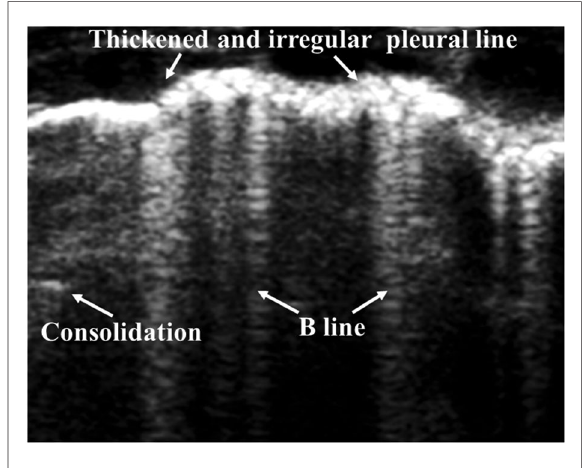
FIGURE 7 Bronchopulmonary dysplasia on lung ultrasonography. Ultrasound shows unequally distributed B-lines, thickened pleural lines, and multiple different-sized subpleural